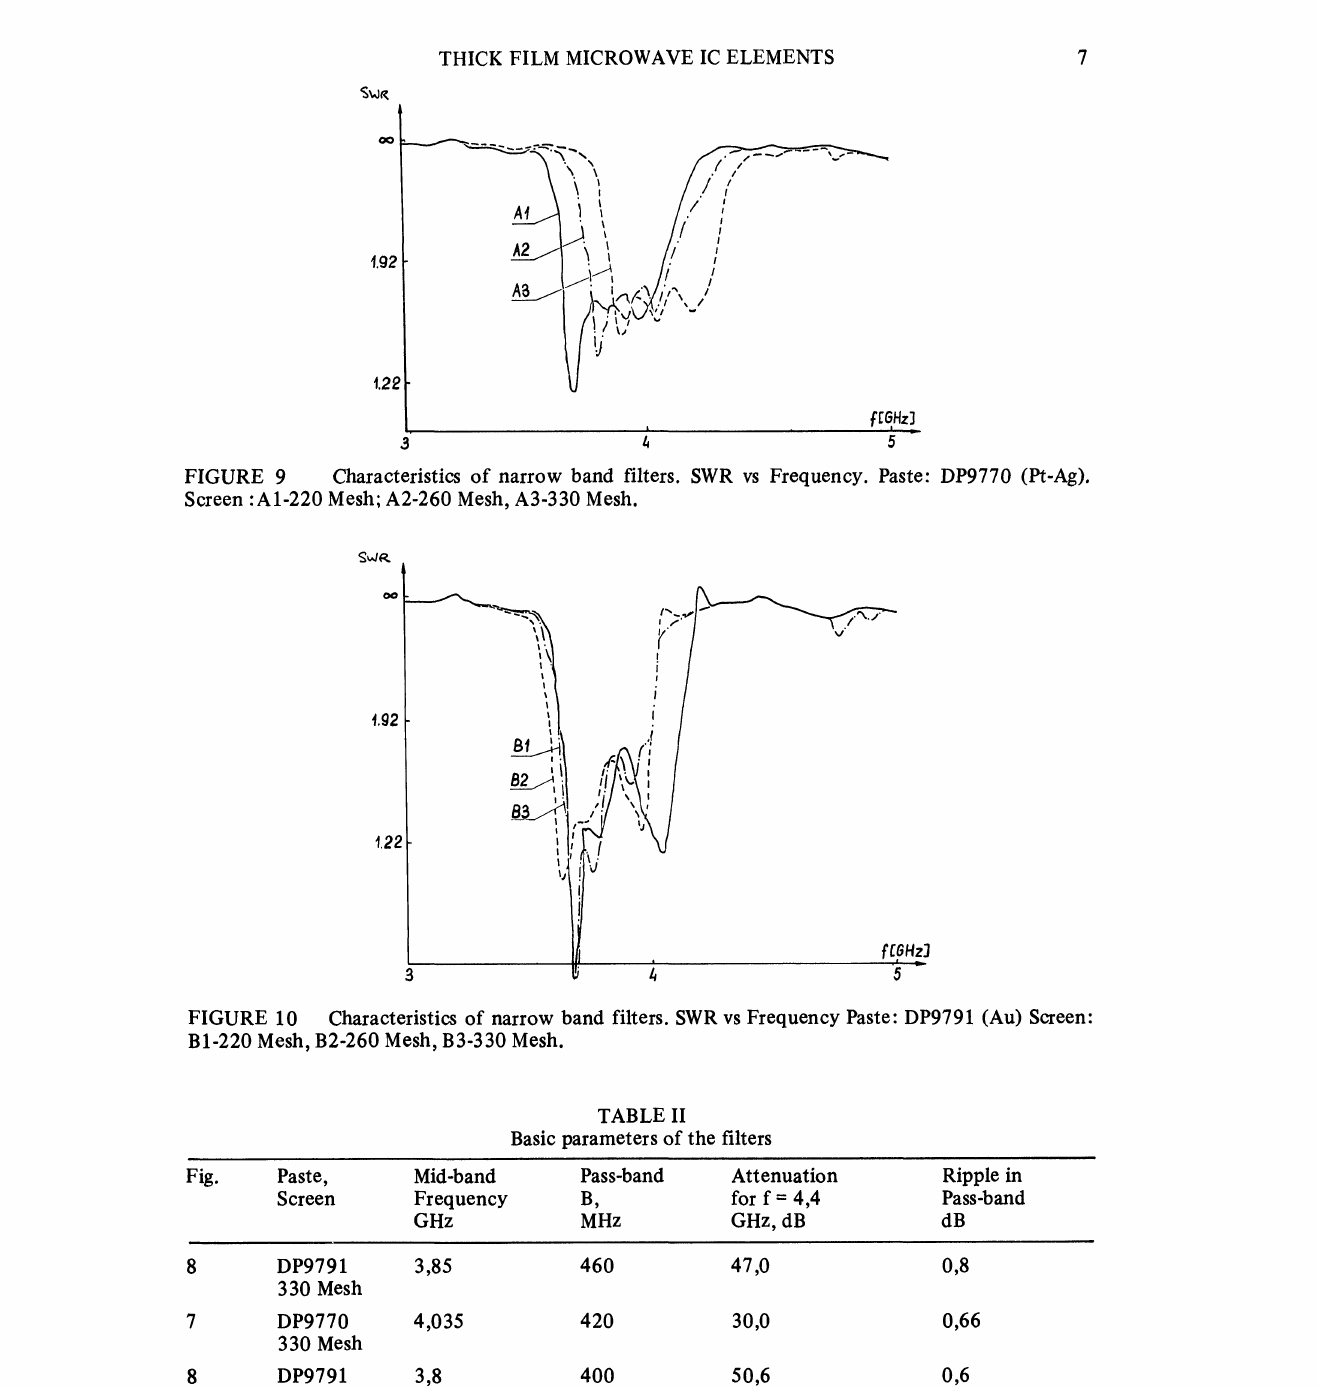
FIGURE 9 Characteristics of narrow band filters. SWR vs Frequency. Paste: DP9770 (Pt-Ag). Screen :A1-220 Mesh; A2-260 Mesh, A3-330 Mesh.